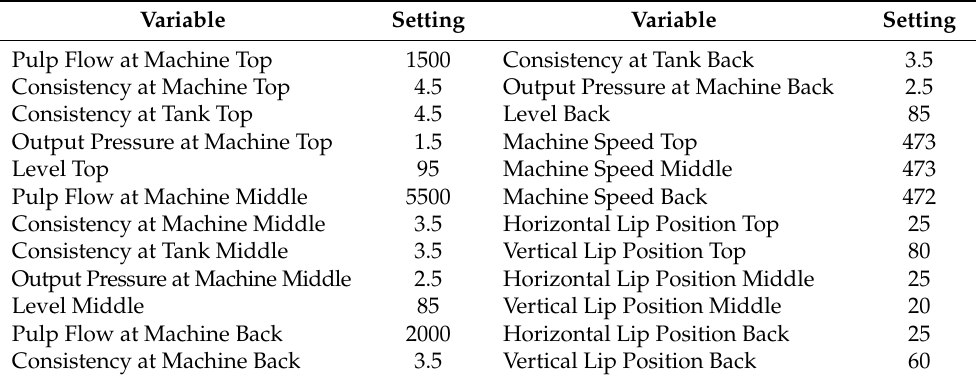
Table 6. Optimal operating conditions for each independent